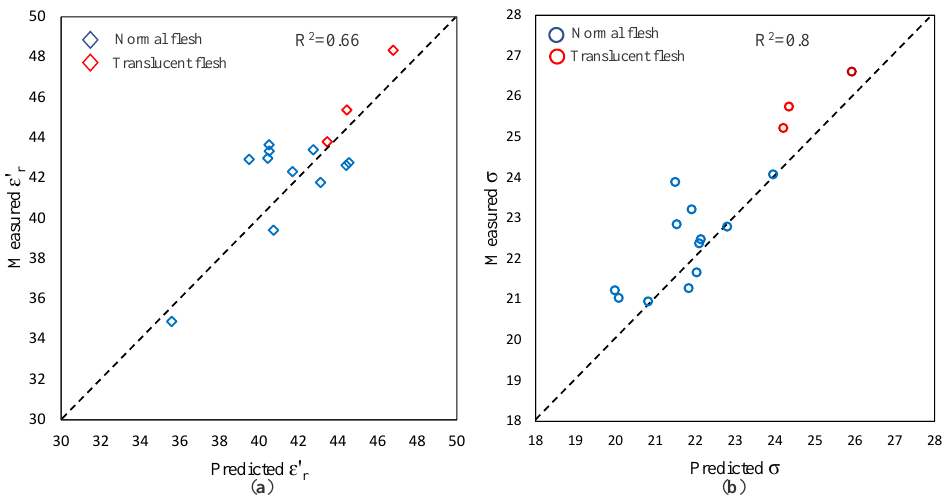
Figure 13. Comparison of the dielectric properties of flesh determined from the backscattered wave measurement and those from a dielectric probe: ( a ) dielectric constant; ( b ) conductivity.